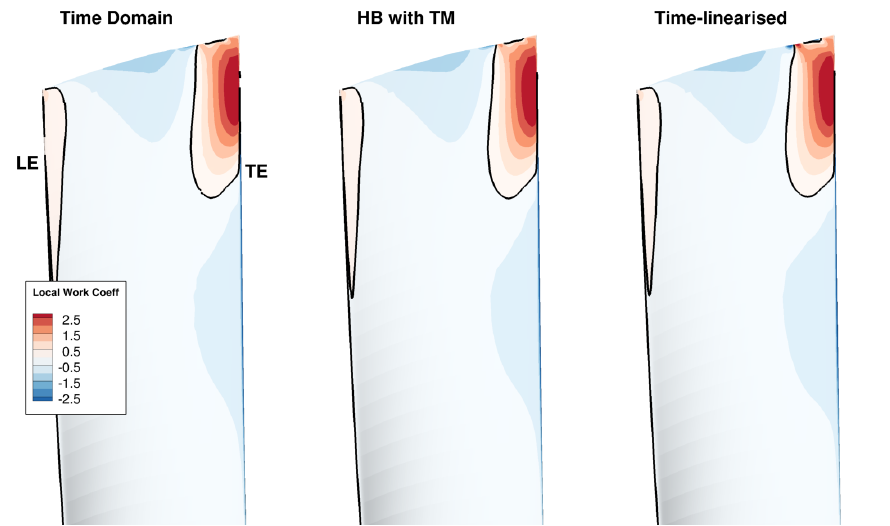
Figure 9. Local work coefficient for σ = − 72 ◦ on the upper half of the pressure side, predicted by time-domain, harmonic balance, and time-linearised solvers. Black lines mark the boundaries between stable and unstable